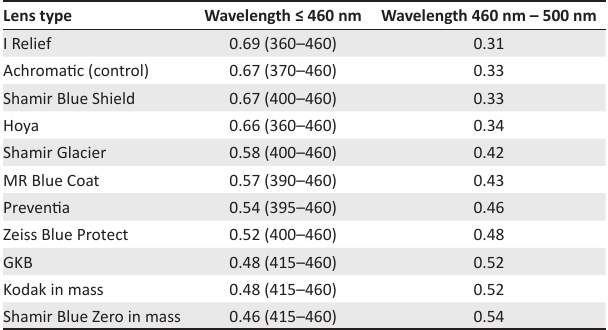
FIGURE 4: Normalised cumulative plots showing the light transmittance beneath the transmissions curve in Figure 3a, b and c over a range of wavelengths for all 11 lenses. The control lens is the achromatic lens showing the area of the light transmitted. TABLE 3: Normalised cumulative values showing radiation transmitted under the transmittance curves as a factor for each lens in Figure